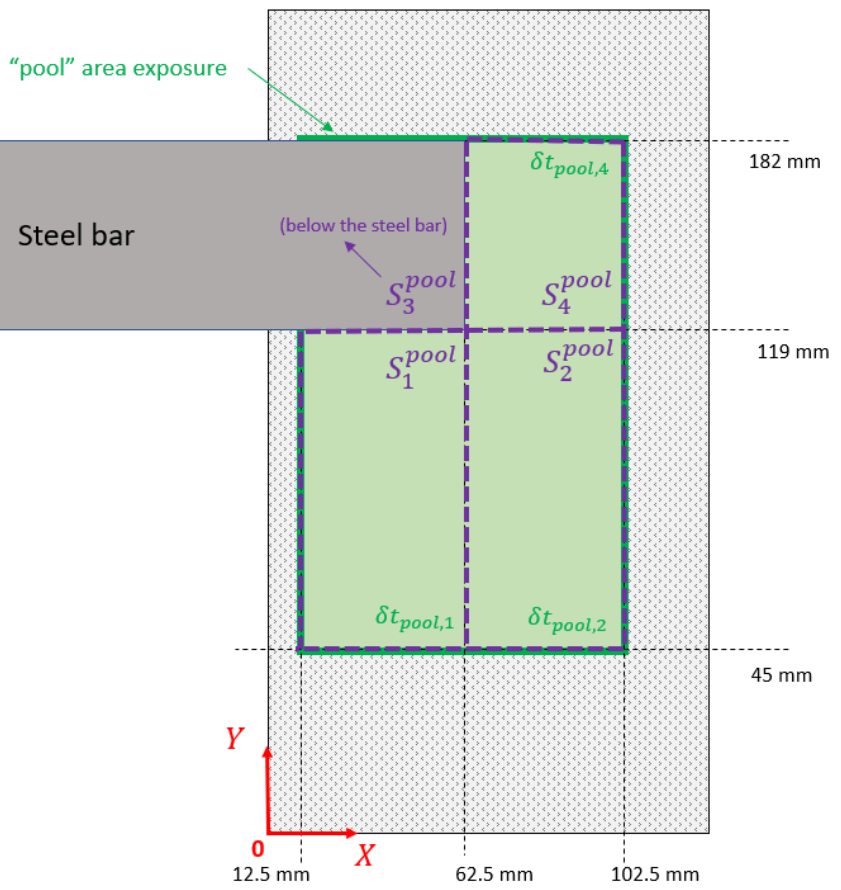
Table 4. Exposure time δt pool,k according to the subzone 𝑆 𝑘𝑝𝑜𝑜𝑙